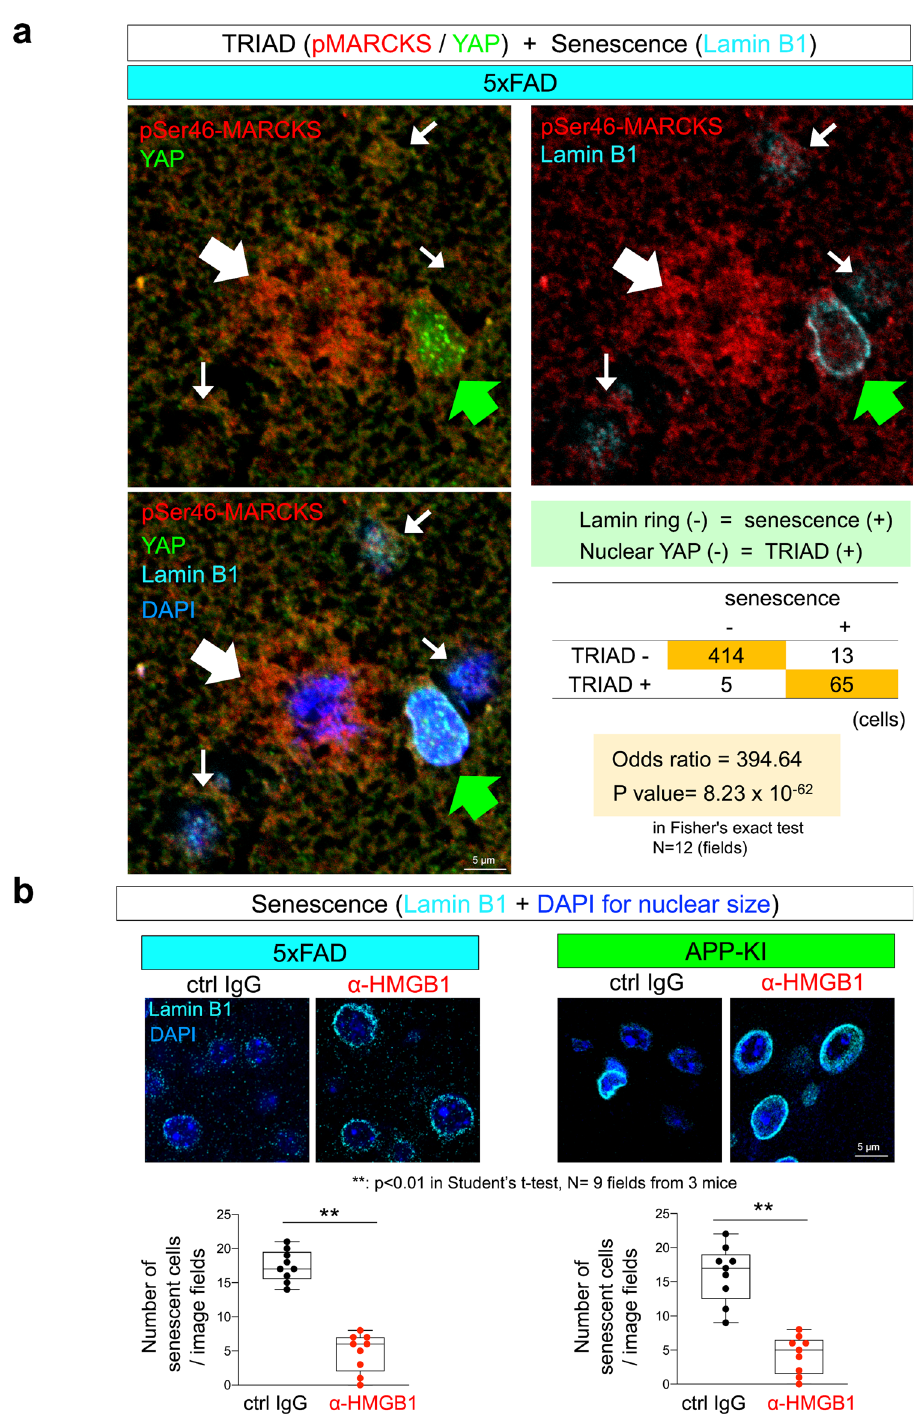
Fig. 8 Overlap of TRIAD and senescence phenotypes in neurons of AD model mice. a Triple staining of the cerebral cortex of AD model mice was performed at 8 months of age. A Lamin B1 ring-negative and nuclear YAP-negative cell (TRIAD-senescence overlapped phenotype) was observed at the center of pSer46-MARCKS stains (thick white arrow). Around the pSer46-MARCKS foci, many Lamin B1 ring-negative and nuclear YAP-negative cells are observed, showing overlap of TRIAD and senescence phenotypes (thin white arrow). Nuclear YAP-positive cells kept Lamin B1 ring (green arrow). The right lower table shows a positive relationship between TRIAD and senescence, and the statistic con fi rmation by Fisher ’ s exact test. b Intravenous administration of human monoclonal anti-HMGB1 antibody (#129) reduced the number of senescent cells both in the cerebral cortex of 5xFAD and APP-KI Interruption of HMGB1 signal recovers synapse . Subcutaneous decrease of dendritic spines (Supplementary Fig. 11d), and or intravenous injection of human monoclonal anti-HMGB1-Ab recovered cognitive impairment (Fig. 6e). Although mouse anti- #129 into 5xFAD mice (Supplementary Fig. 11a) suppressed HMGB1-Ab did not signi fi cantly alter the number and area of the MARCKS phosphorylation at Ser46 in immunohistochemistry A β plaques 38 , human antibody #129 suppressed extracellular A β aggregates (Supplementary Fig. 11e). Similarly, in APP-KI mice and western blot analyses (Supplementary Fig. 11b, c), recovered